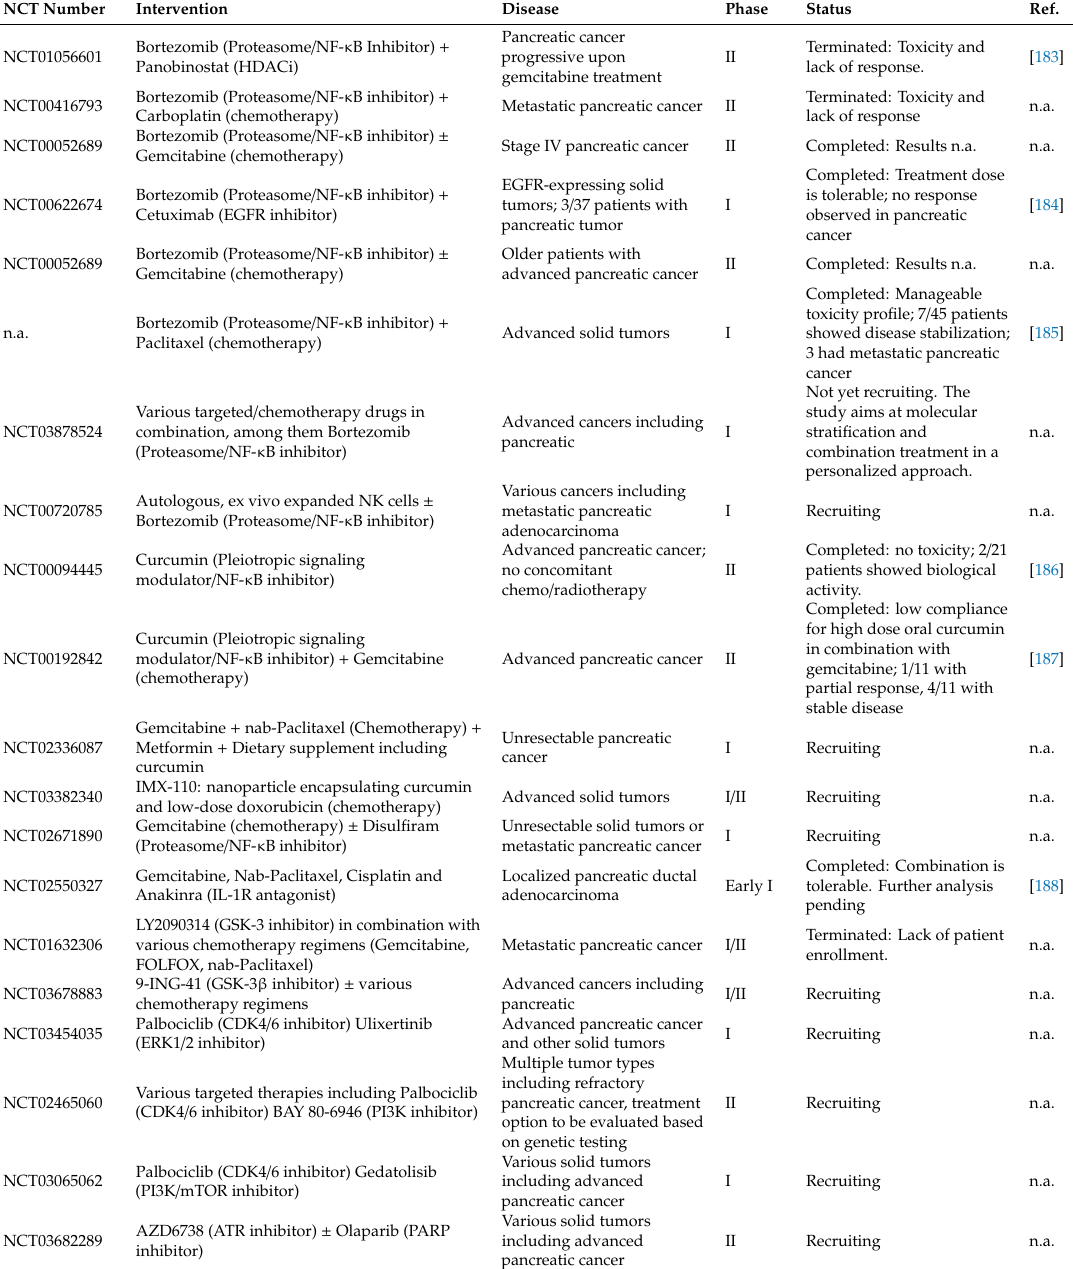
Table 1. A selection of clinical trials for pancreatic cancer targeting NF- κ B signaling or its associated pathways are given. Abbreviations as followed; n.a.: non-applicable, HDACi: histone deacetylase inhibitor, NK: natural killer cells, IL-1R: interleukin 1